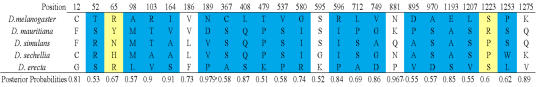
Phylogenetic Analysis of Positive Selection at Individual CodonsSite-specific codon Model 8 (M8) in PAML was used to identify codons under selection. This model, which considers a discrete distribution of DN/Ds values plus a “selection category”—DN/DS values greater than one—fit the data better than a neutral model (M1) (2Δ| = 25.43, p < 0.001). Codons listed are those with p-values from posterior distributions greater than 0.5. The positions of these codons are also shown in Figure 4. Because D. melanogaster is incompatible with all three of its sibling species, we expect that Hmr codons involved in HI must be different between D. melanogaster Hmr and all three sibling-species alleles. Codons that fit a model of incompatibility between Hmrmel and Asib are shaded blue, and those that fit a model of incompatibility between Hmranc and Asib are shaded yellow (see Discussion). The five remaining codons (unshaded) are identical between D. melanogaster and at least one of the sibling alleles and are thus excluded from both models.